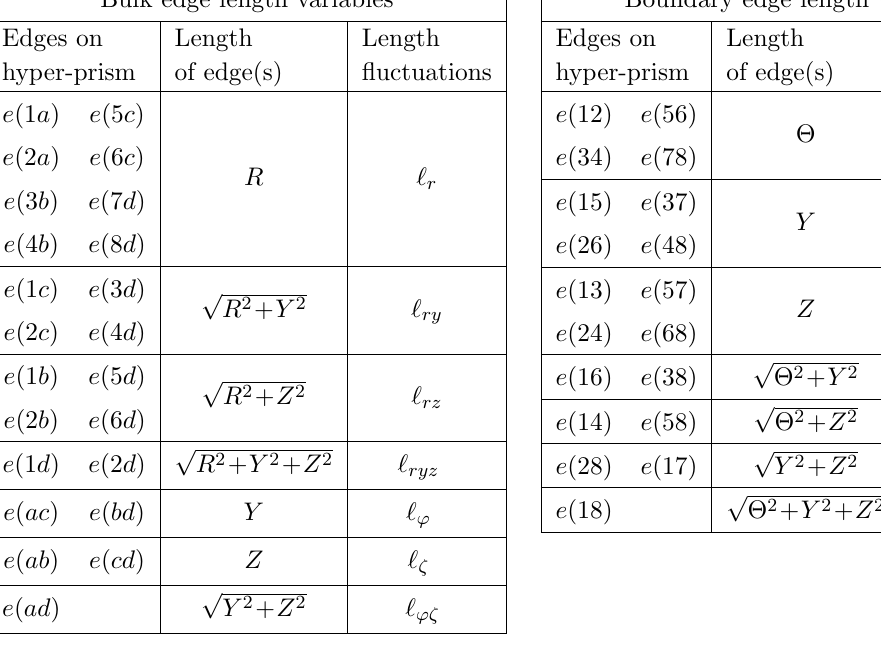
Table 1 . The tables relate the length variables to the edges in the hyper-prism, which are shown in (cid:12)gure 3. The left table includes all edges that are in the bulk of the solid three-torus. The right table includes all the edges that are in the boundary of the solid